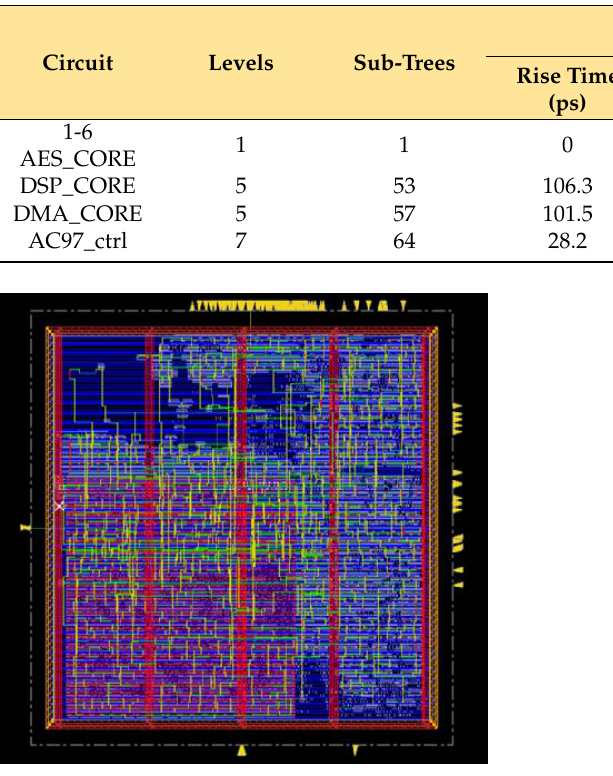
Figure 5. Layout: Clock tree after implementation of proposed methodology in DSP_Core.